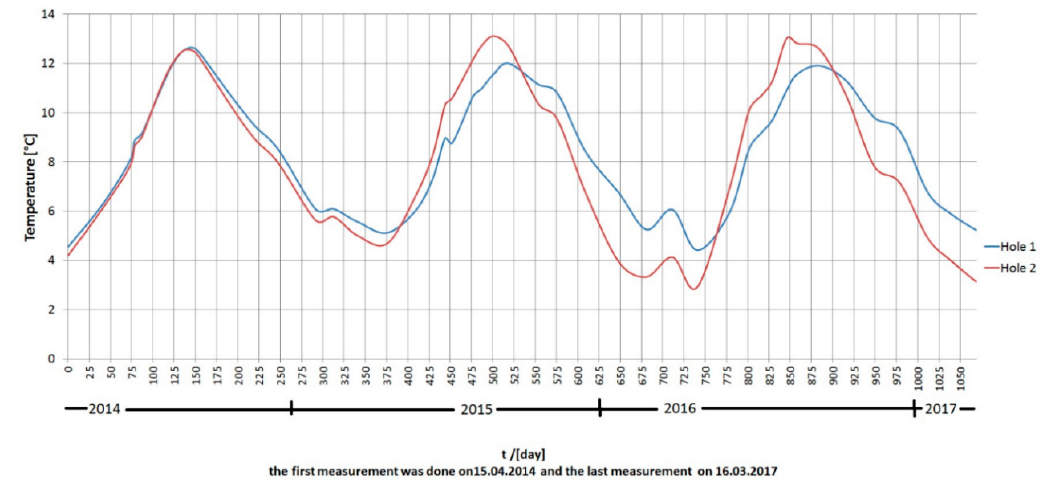
Figure 5. The temperatures in the soil at a 1.5 m depth under the asphalt layer.